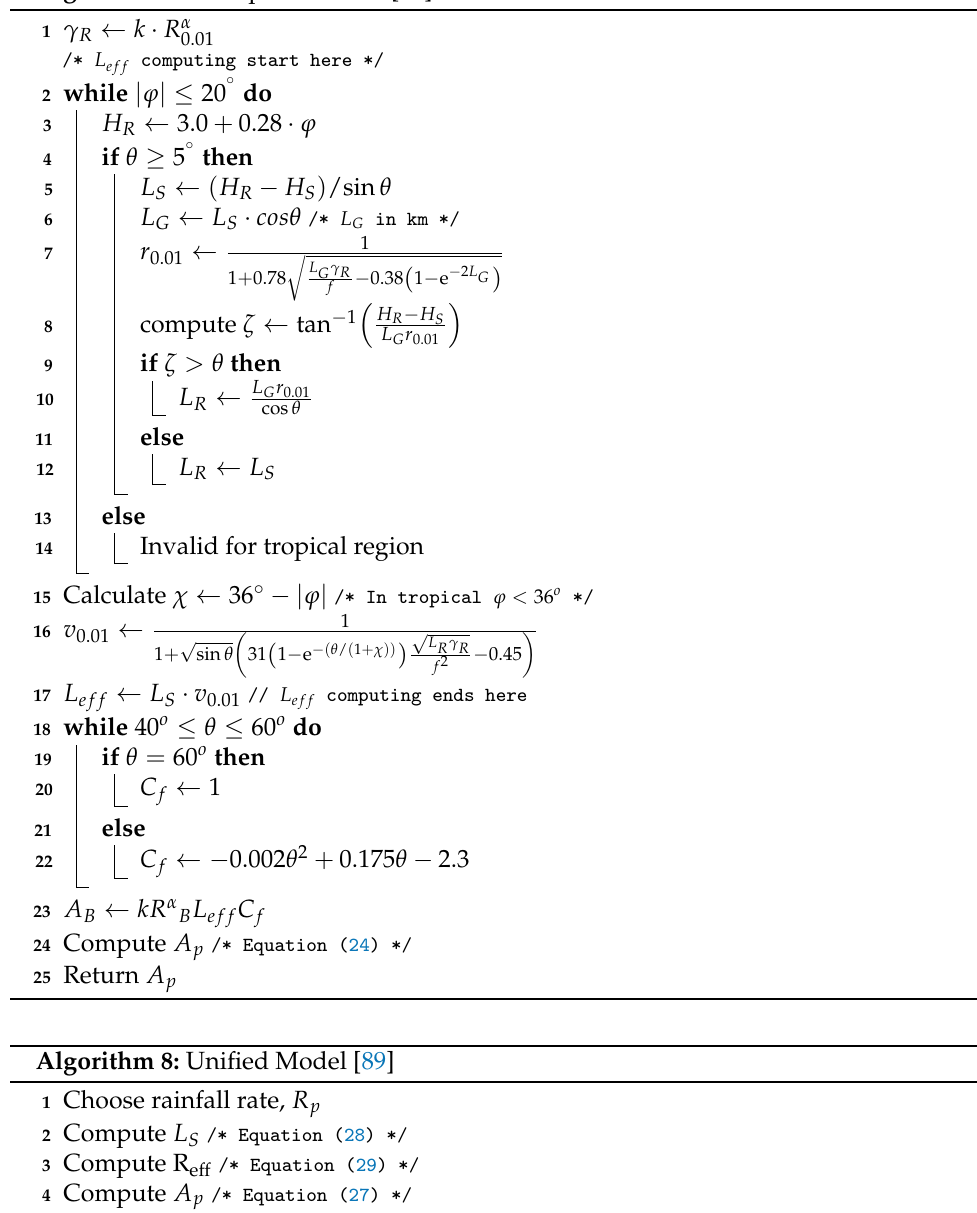
Algorithm 7: Breakpoint Model [29]